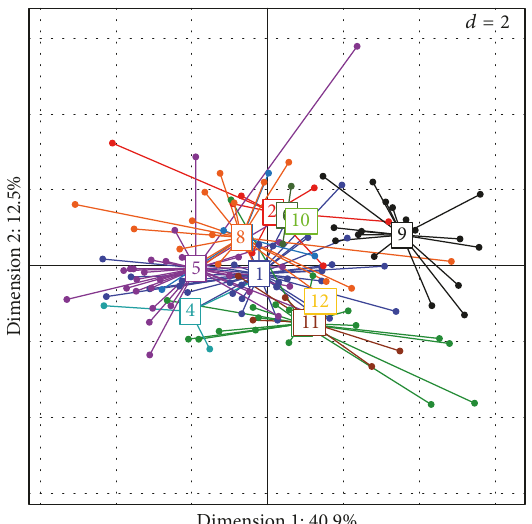
Figure 8: PCA for the 146 genotypes in the EETP collection for the vigor traits in 2012.